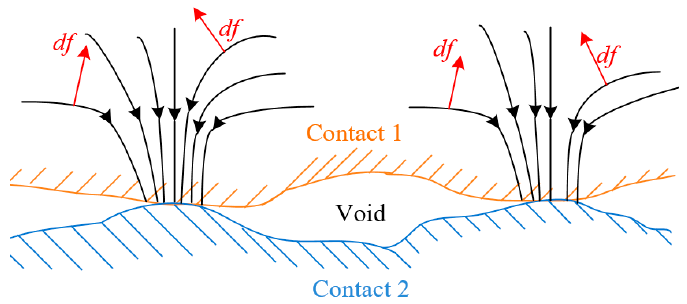
Figure 5. Force analysis of contacts.